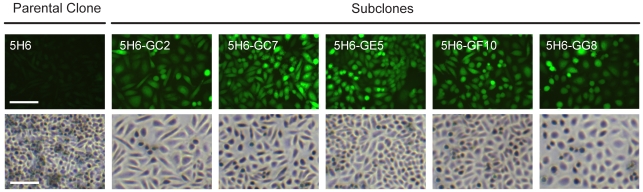
In-situ fluorescence and morphology of sorted subclones.Fluorescence and phase contrast images of the parental clone (5H6) and subclones (5H6-GC2, -GC7, -GE5, -GF10, -GG8) in adherent culture 24 days after subcloning. Scale bars, 100 µm.